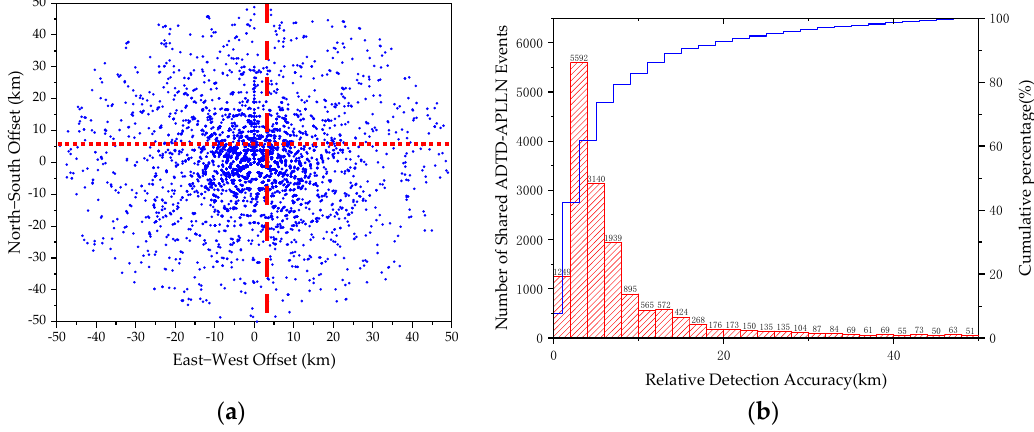
Figure 15. ( a ) Location offsets between the shared strokes, taking each ADTD stroke as the origin and plotting the corresponding APLLN stroke relative to it (ADTD − APLLN). The mean north–south offset is 5.43 km, displayed as the dotted red line, and the mean east-west offset is 4.35 km, displayed as the dashed red line. ( b ) Distribution of relative location accuracy. The solid blue line indicates the cumulative percentage of shared events.